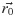
Model sensitivity calculated through exploring phase space.Sensitivity analysis examining the goodness of fit of the generalized SPP model to displacement distributions in mouse fibroblasts (1 − R2) as a function of model parameters. (A) Contour plot of log(1 − R2) illustrates the experimental data tightly constrains a linear combination of the mean velocity μv and mean noise μD, where the minima is highlighted by a white circle. (B, C) The goodness of fit as a function of each model parameter while all others are held fixed. (B) r0→ is the optimal coordinate in parameter space and r→-r0→ is the distance of each parameter from its optimal value. (C) A value of τ smaller than ≈ 10 is inconsistent with experimental data, but data does not discriminate between larger values of τ.